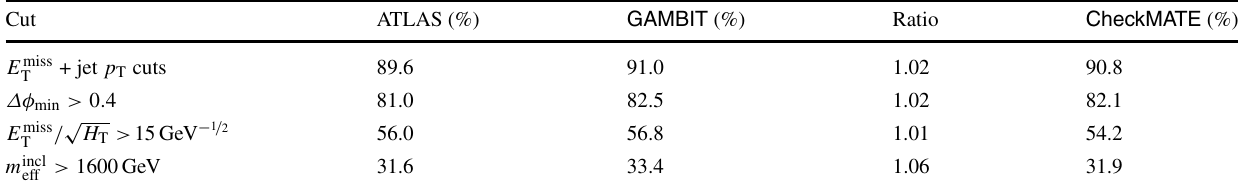
Table 3 The published ATLAS cutflow for the 2 jt signal region taken This is compared with the GAMBIT cutflow obtained using Pythia8 from Ref. [49], which searched for squarks and gluinos in events with and BuckFast . Shown are the efficiencies for passing each cut (second jets and missing transverse momentum. The cutflow is generated for a and third columns), and the ratio of efficiencies (fourth column). For squark pair-production simplified model (in which a pair of squarks is reference, we also show the cutflow results obtained using the Check- MATE package (taken from their public validation results) [29] produced with direct decay to a quark and a lightest neutralino, all other = 100GeV. sparticlesbeingdecoupled),with m ˜ q = 1000GeVand m ˜ χ 0 1